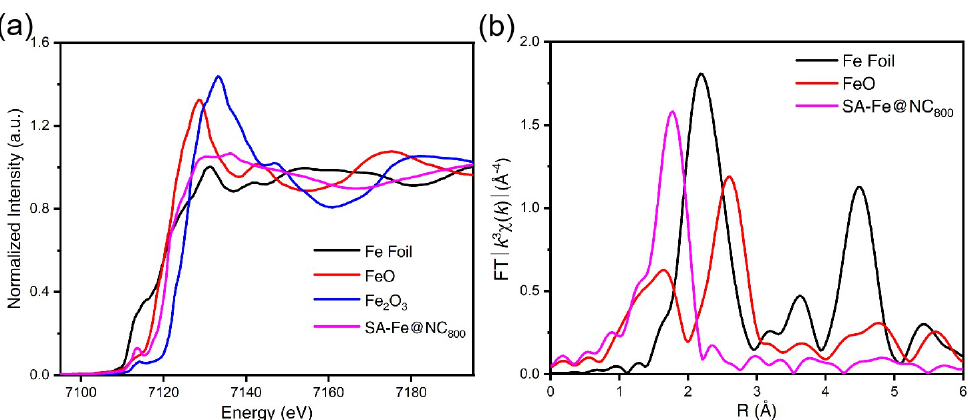
Figure 4. ( a ) XANES spectra at the Fe K-edge of the SA-Fe@NC 800 , FeO, Fe 2 O 3 and Fe foil. ( b ) Fourier transform (FT) at the Fe K-edge of the SA-Fe@NC 800 , FeO and Fe